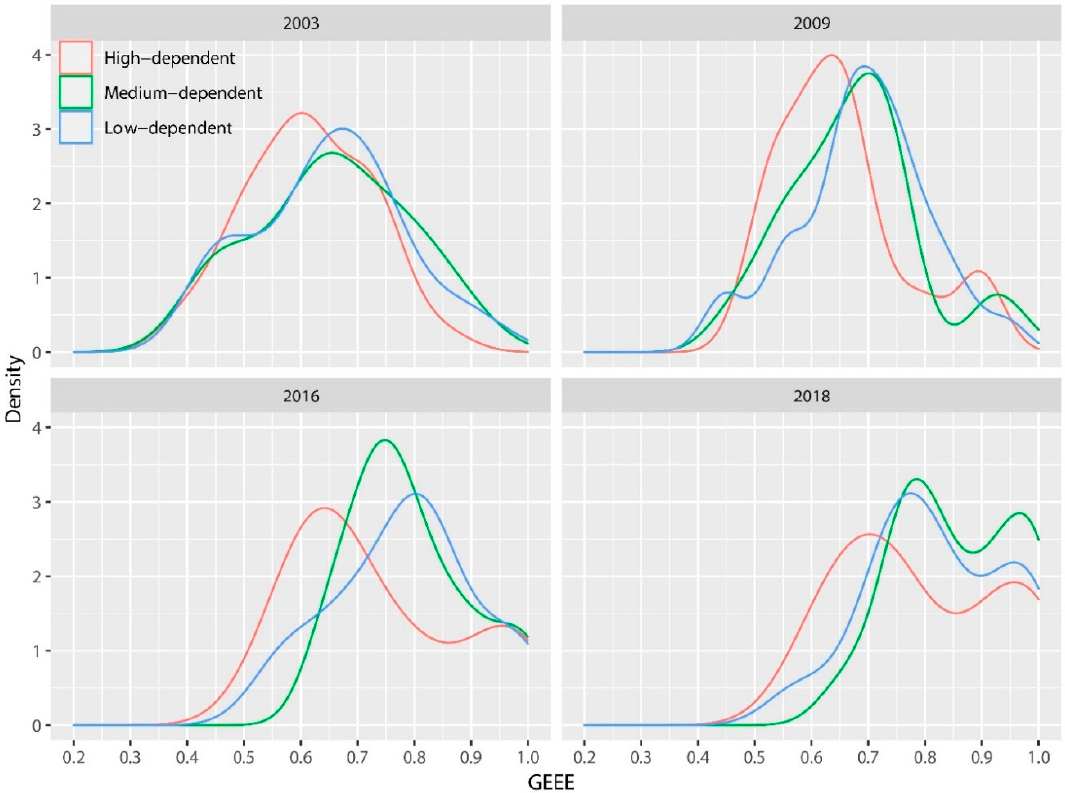
Figure 2. Densitydistributionofglobalenergyandenvironmentalefficiency(GEEE)forclassificationbyRD. Int. J. Environ. Res. Public Health 2020 , 17 , 4795 Figure 2. Density distribution of global energy and environmental efficiency (GEEE) for classification by RD.